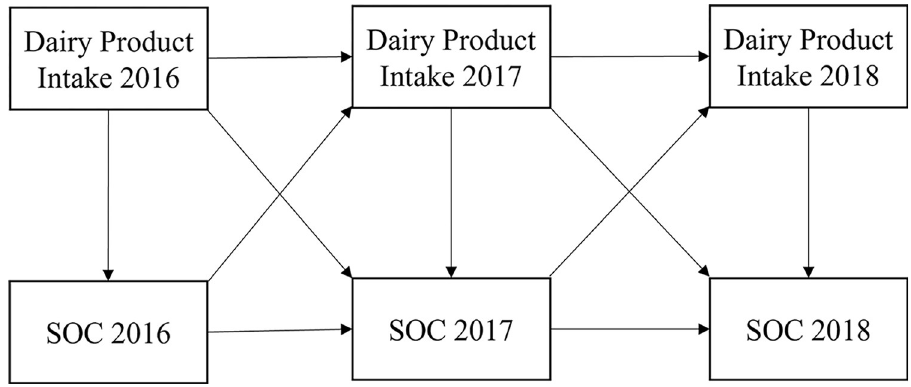
Fig 1. Conceptional model of the association between SOC and dairy product